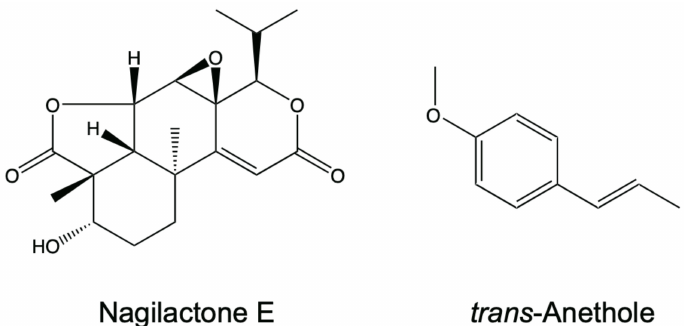
Figure 1. Chemical structures of nagilactone E and trans